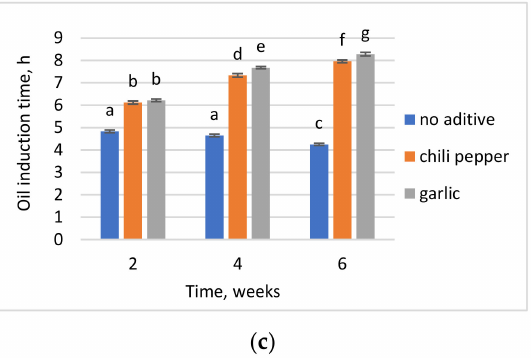
Figure 3. Effect of additives on the oxidation induction time of stored oils: ( a )—flax seed oil; ( b )— hemp seed oil; ( c )—black cumin seed oil. The values designated by the different small letters are significantly different ( α =